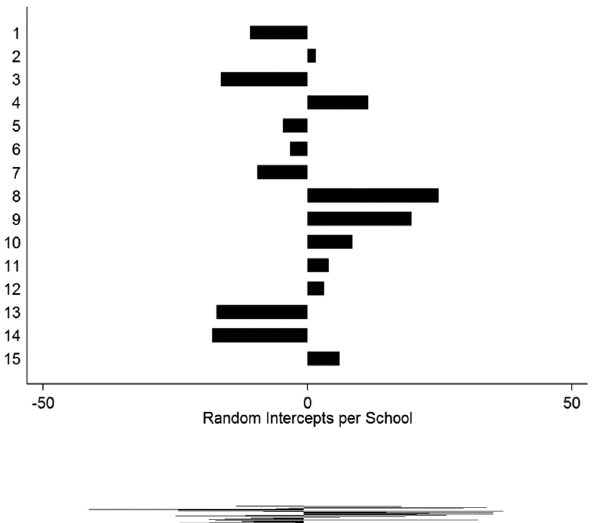
Figure 8. Random intercepts per student